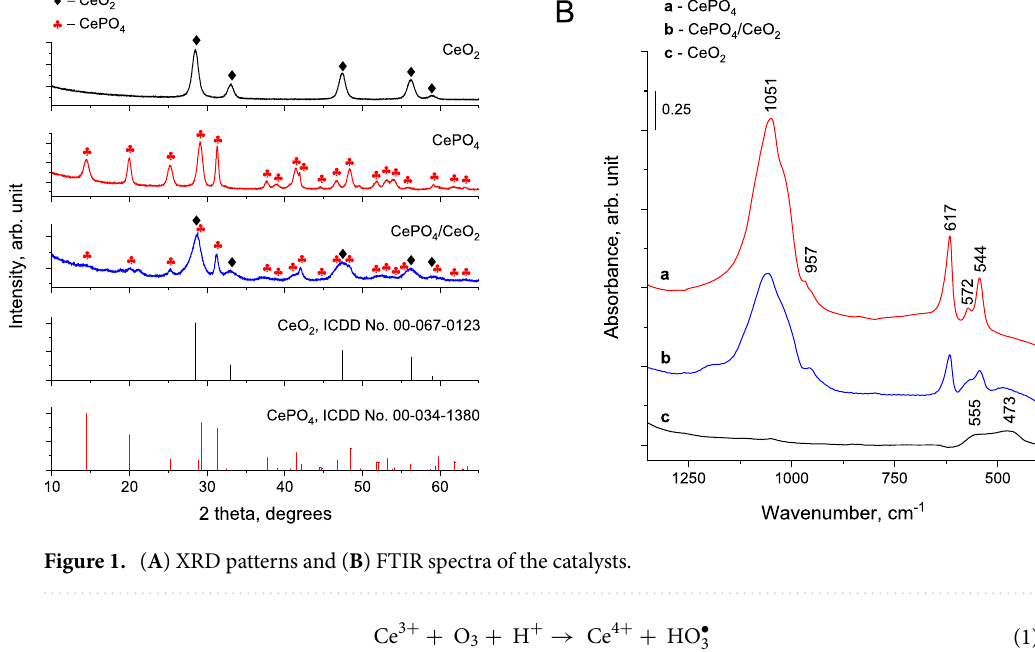
Figure 1. ( A ) XRD patterns and ( B ) FTIR spectra of the